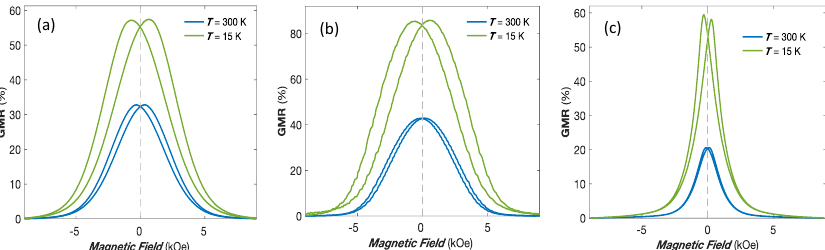
the IP direction.